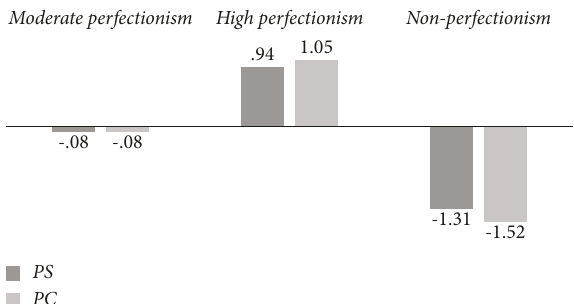
Figure 1: Graphic representation of the standardized average scores for the model of the latent